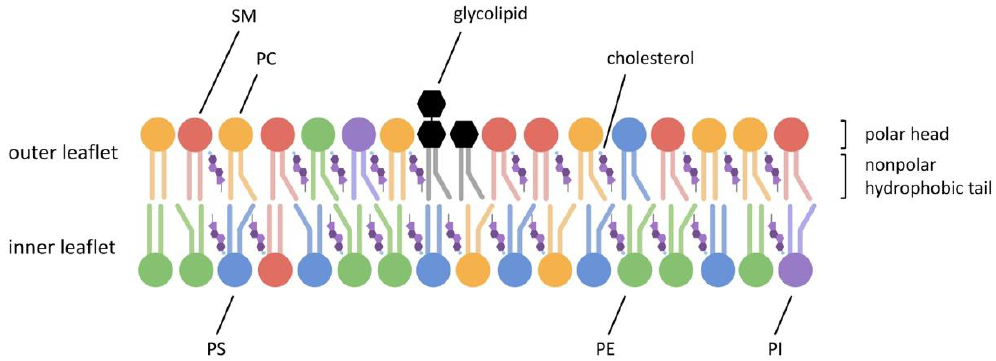
Figure 2. Phospholipid asymmetry of sperm plasma membrane. Sphingomyelin (SM) and phosphatidylcholine (PC) are mainly present in the outer leaflet, while phosphatidylethanolamine (PE) and especially phosphatidylserine (PS) are located in the inner leaflet. Glycolipids are usually found in the outer leaflets of plasma membranes and are mainly used to maintain membrane stability and facilitate intercellular communication. Cholesterol molecules are randomly distributed over the phospholipid bilayer, binding the phospholipids together and limiting the fluidity of the membrane. During capacitation, the sperm plasma membrane first undergoes a substantial loss of cholesterol, accompanied by a decrease in phospholipids and loss of asymmetric distribution of phospholipids.